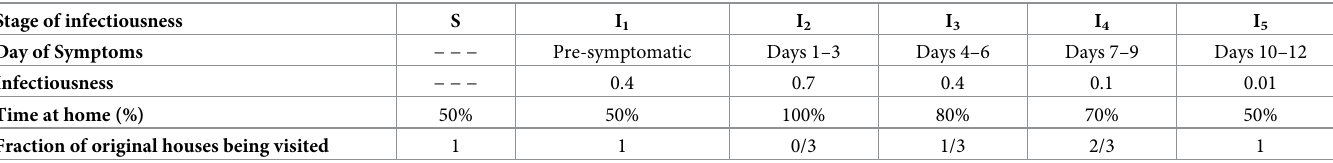
Table 2. Parameters that vary by infectiousness stage.